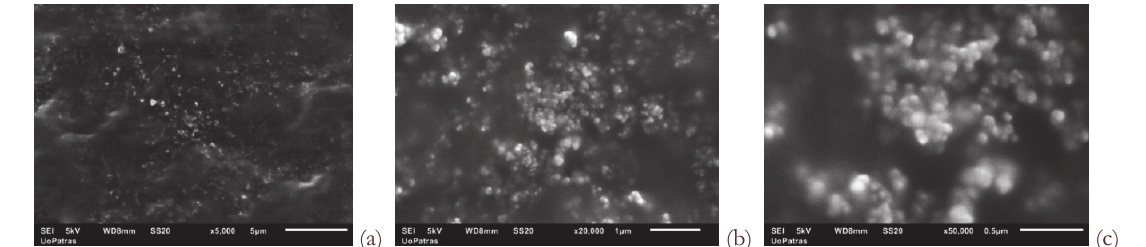
Figure 2: SEM photos of an area in the MWCNT/PP 2 wt%_03 specimen: a. x5,000, b. x20,000 and c. x50,000.